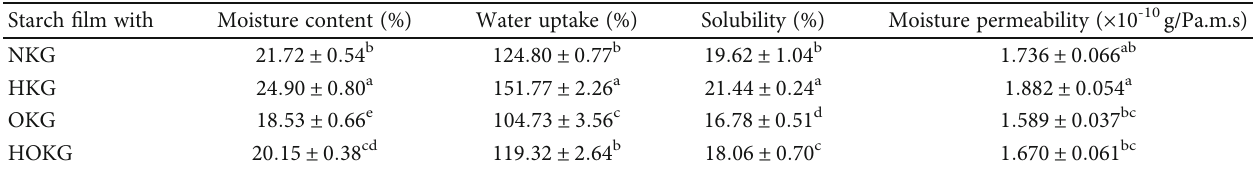
Starch fi lm with